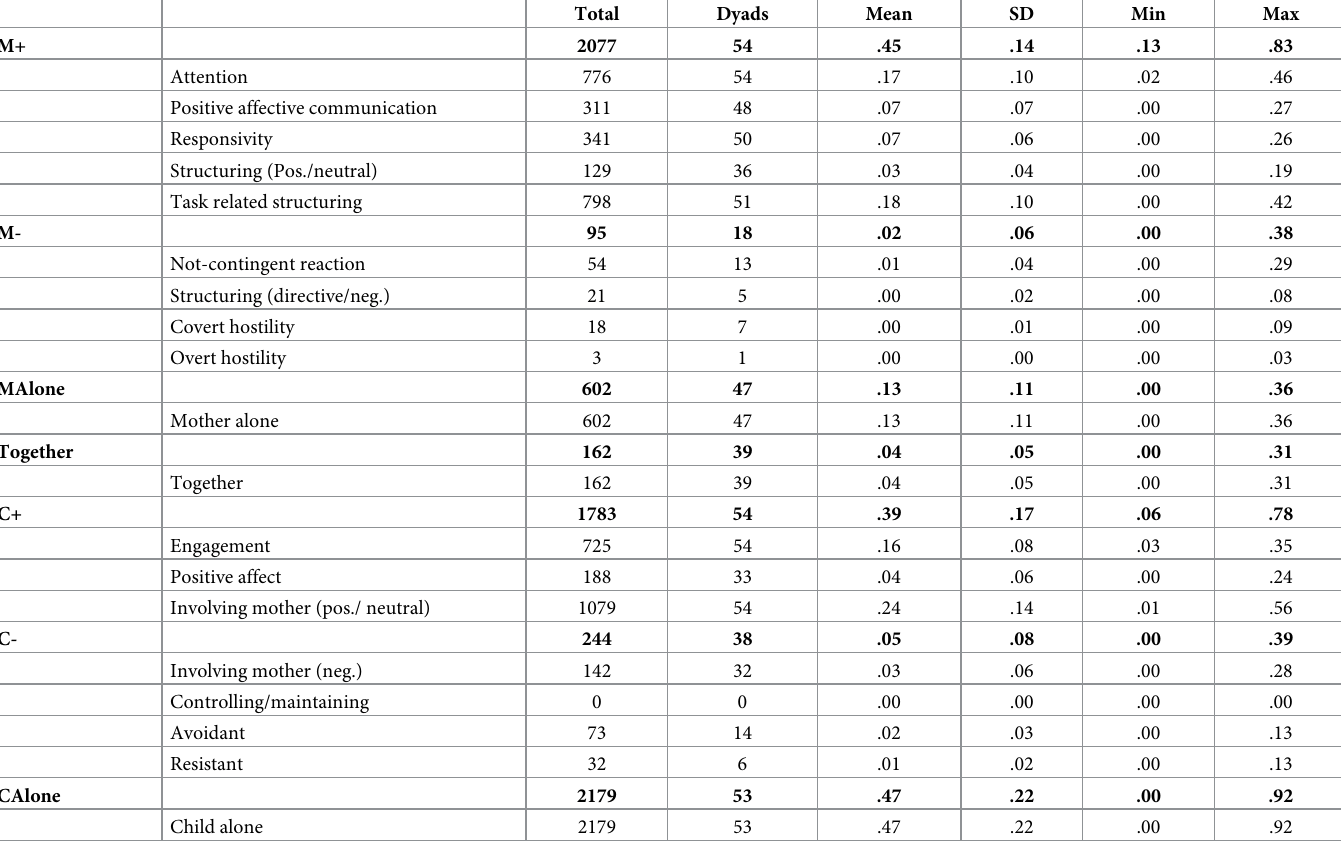
Table 3. Relative frequencies of mother and child behaviors of the MCAM. Total time of occurrence, number of dyads showing the behavior (Dyads), mean, standard deviation (SD) and range (Min, Max) for the